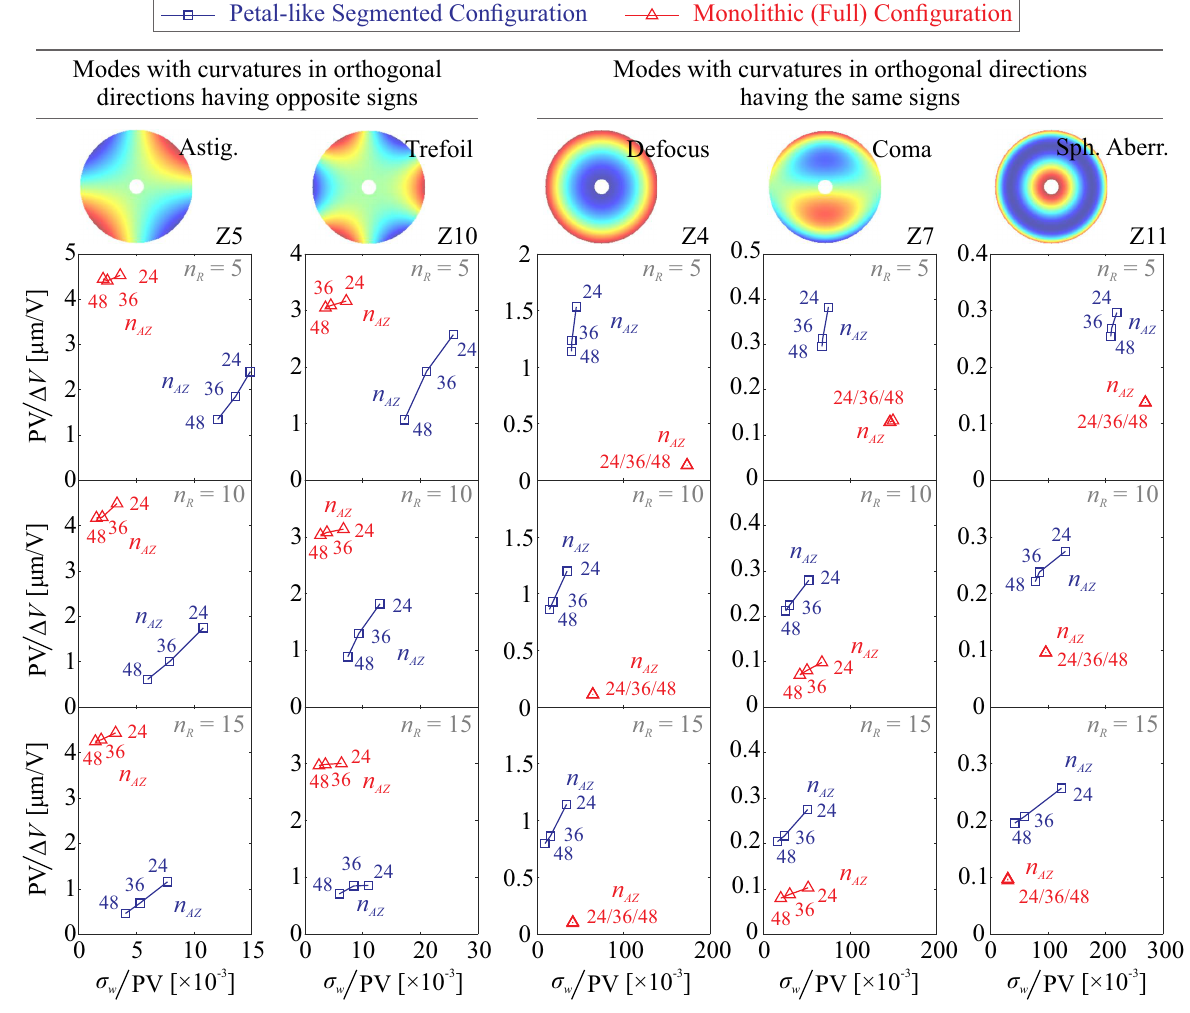
Figure 8. Simulated results of forming low-order Zernike modes with the layer of various reflector configurations and patterned electrodes shown in Figure 7, with both the wavefront RMS error σ w and voltage range ∆ V computed. According to those results, significantly larger amplitudes of the deformation can be found for petal configurations, for generating a target shape where the curvatures in orthogonal directions have the same signs; the monolithic configuration shows better performance in both morphing strokes and surface precision when forming a target shape where the curvatures in orthogonal directions have opposite signs that are wavy on the edge. Table 2. Numerical results of controlled surface precision (wavefront RMS error) of forming 10 µ m amplitude Zernike modes of primary optical